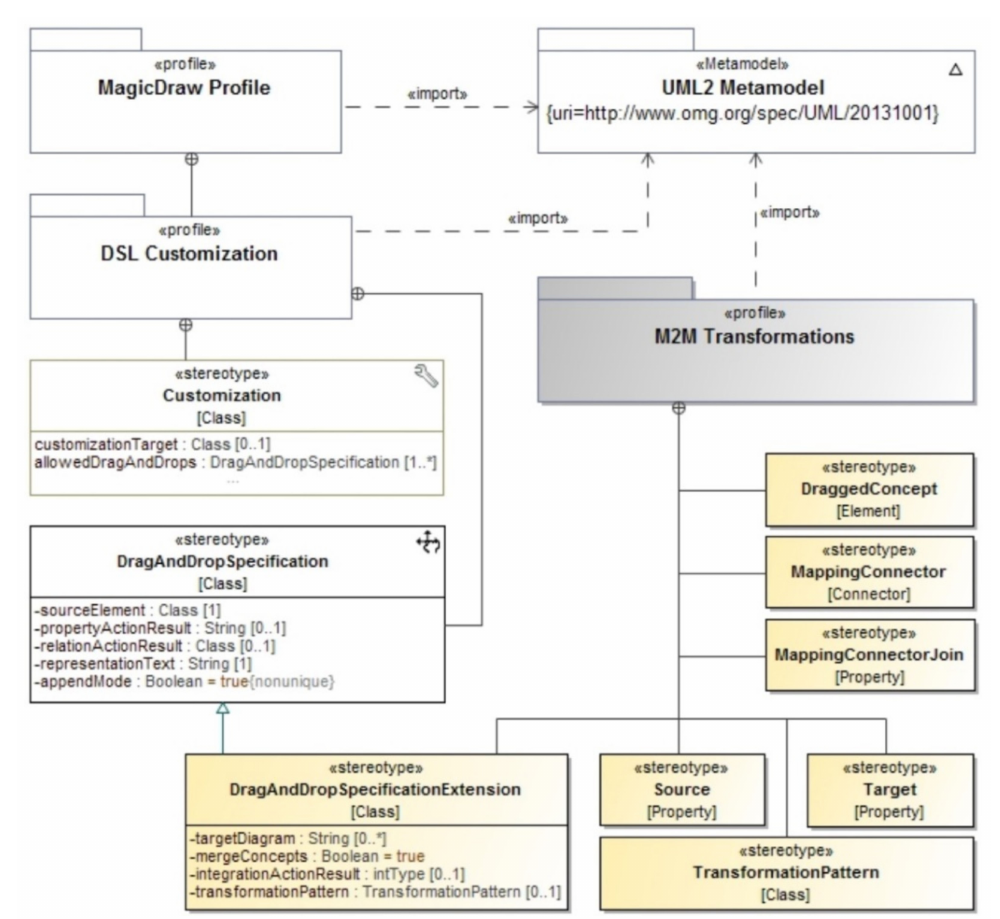
Figure 2. The overall architecture of UML profiles for supporting DnD transformation